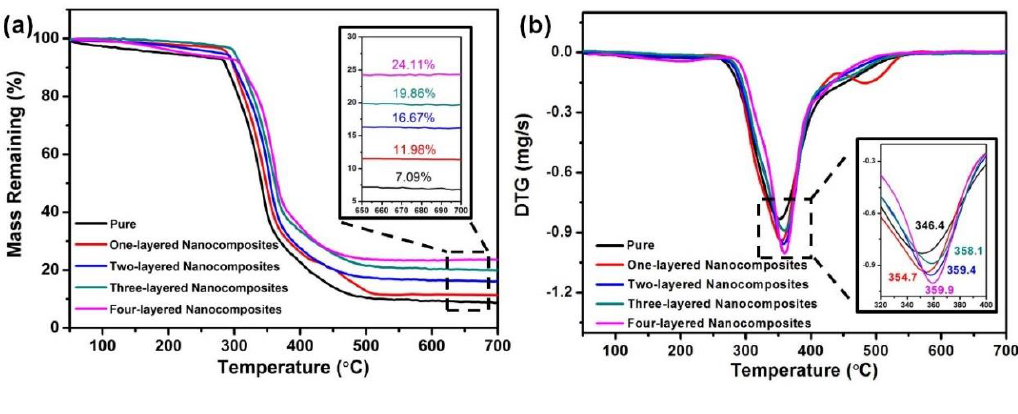
Figure 8. ( a ) Typical TGA curves; ( b ) DTG curves of pure epoxy polymer and CMC/buckypaper/epoxy nanocomposites.